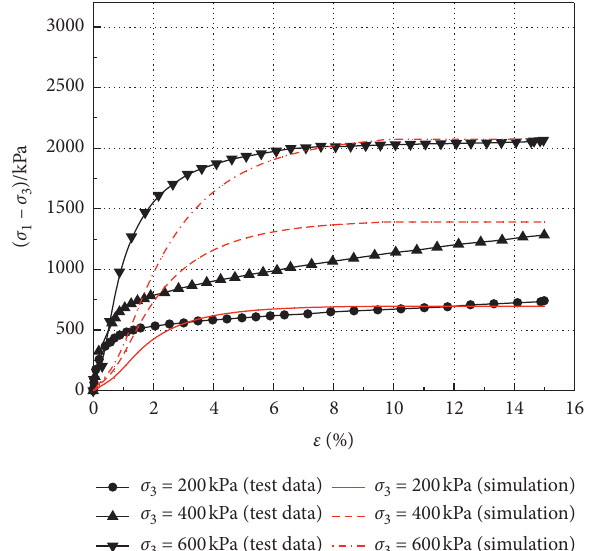
Figure 22: Relationship between the test results and